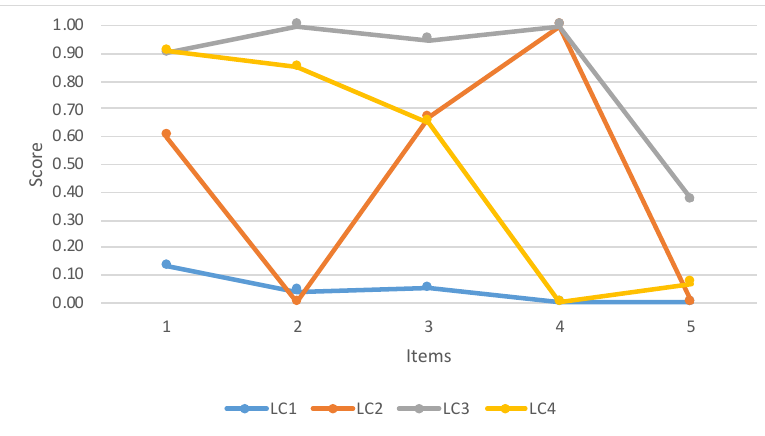
Figure 1. Results of the four latent class (LC) model.